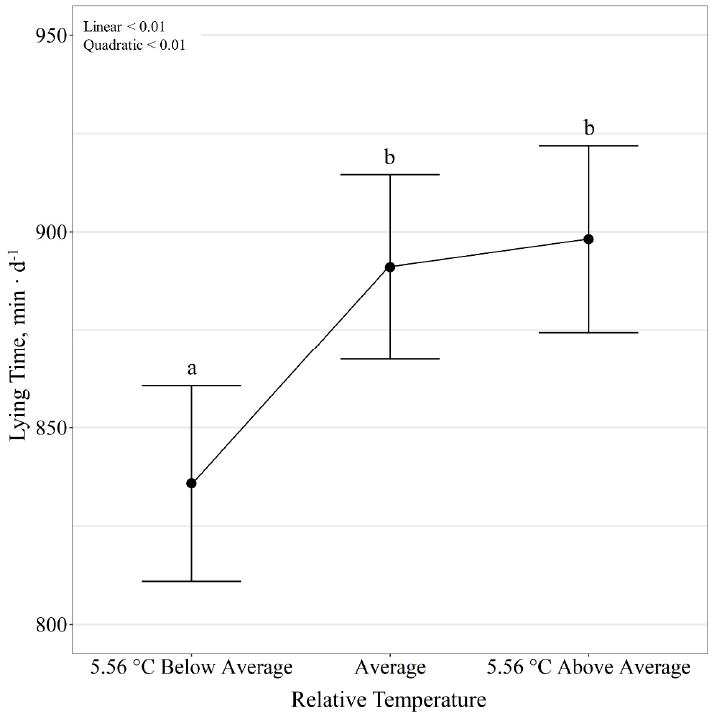
Figure 5. Influence of relative temperature change on lying time ( p < 0.01; expressed as min d − 1 ) by beef steers consuming either barley or corn-based feedlot diets at the Northern Agricultural Research Center, Havre, MT, USA. Data points without a common letter differ ( p < 0.05).